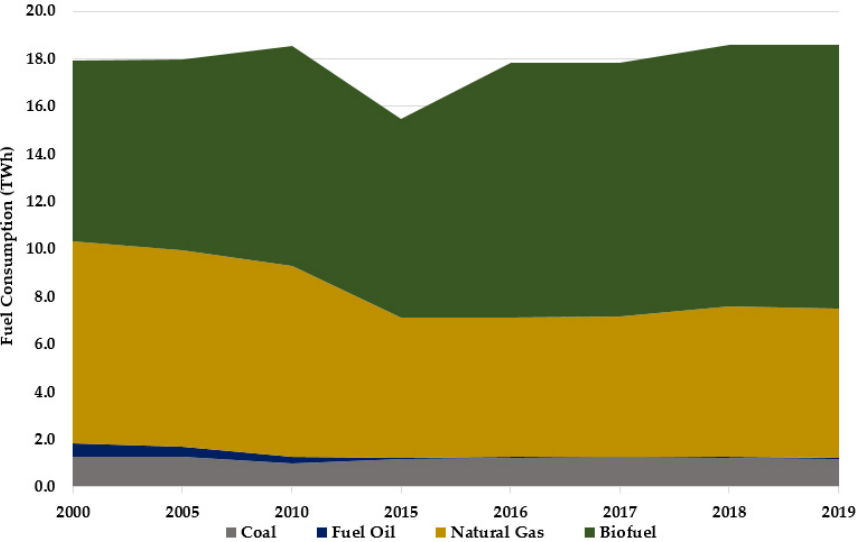
Figure 3. Historical trend of fuel consumption in the P&P industry in Austria [9,29–33].